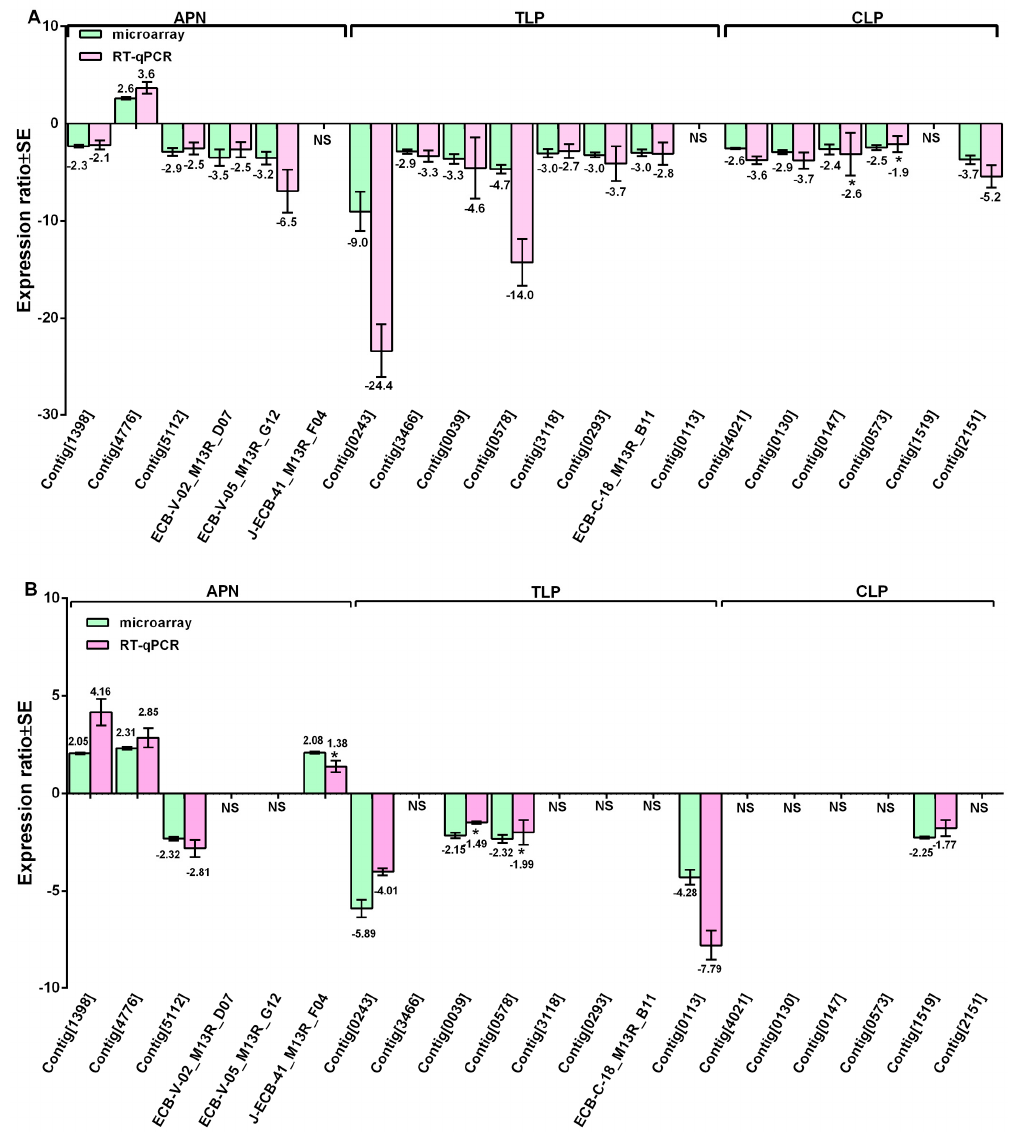
Figure 2. Comparison of microarray (green bars) and reverse transcription quantitative PCR (RT-qPCR) (pink bars) analyses for three functional groups of the gut genes with significantly differential expressions in S-strain ( A ) and R-strain ( B ) of O. nubilalis larvae fed transgenic Cry1Ab corn leaves relative to non-transgenic corn leaves. Aminopeptidase (APN), trypsin-like proteases (TLP), and chymotrypsin and chymotrypsin-like proteases (CLP). “NS” indicates the gene did not show significantly differential expression. The symbol “*” indicates that RT-qPCR of the genes did not show significant difference between transgenic corn Cry1Ab and non-transgenic corn treatments ( p > 0.05).